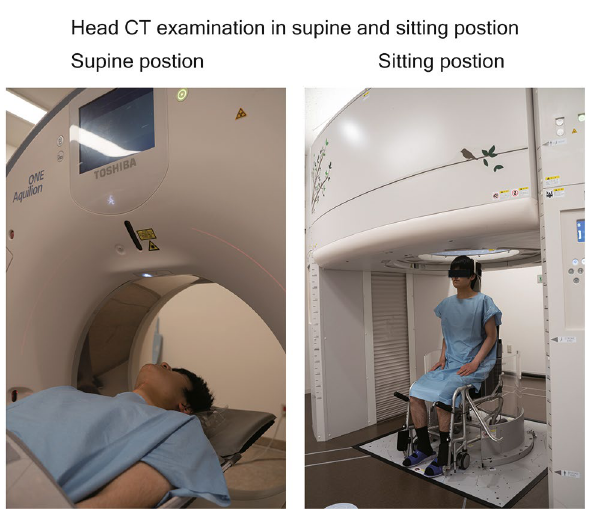
Figure 1. The CT examination in supine (left image) and sitting position (right image). In both the upright and conventional CT scanner, the subjects were instructed to keep their back straightened and look straight